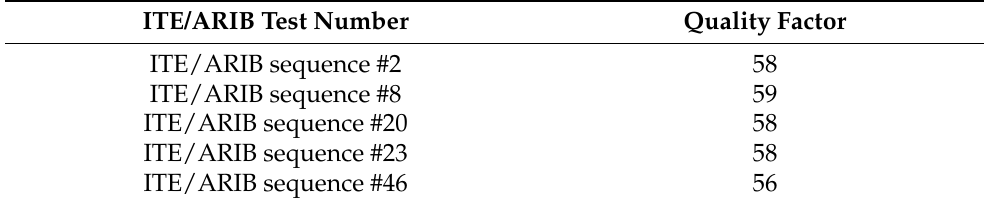
Table 1. Quality factor to generate less than 1/100 of the original bit